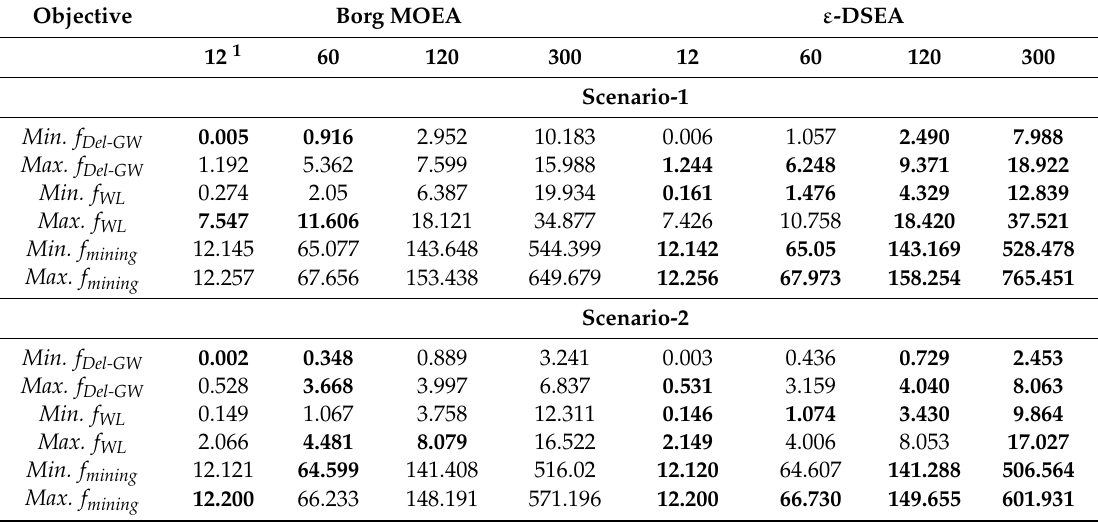
Table 5. Median summary of the best achievement for both algorithms under two irrigation alternative scenarios. The superior results are in bold (smallest values for minimum and largest values for maximum).